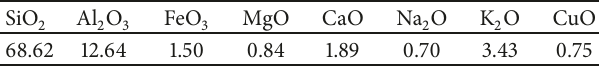
Table 1: Chemical composition of zeolite (%